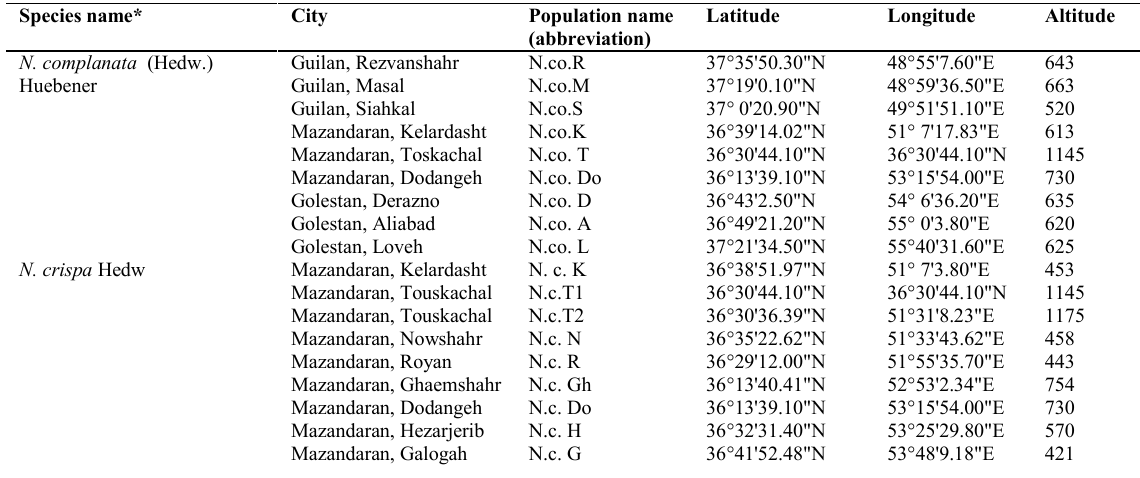
Table 1. Collection information (location, abbreviation, latitude, longitude, and altitude) of 18 populations of two species of Neckera genus ( N . complanata and N. crispa) with nine populations in each in the north of Iran.